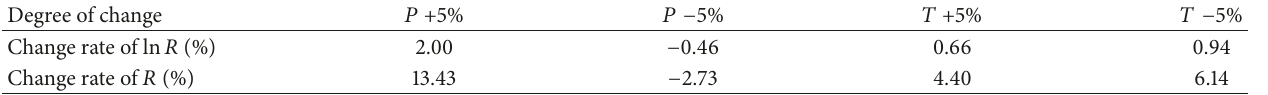
Table 9: Results of 𝑅 changes with the elements changes.